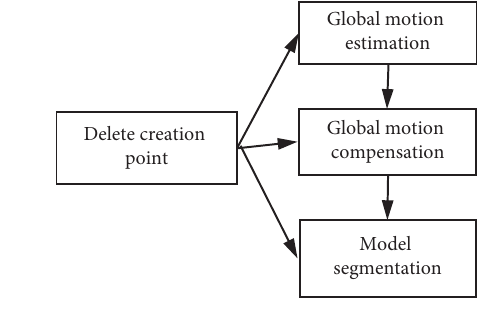
Figure 1: Method flowchart.